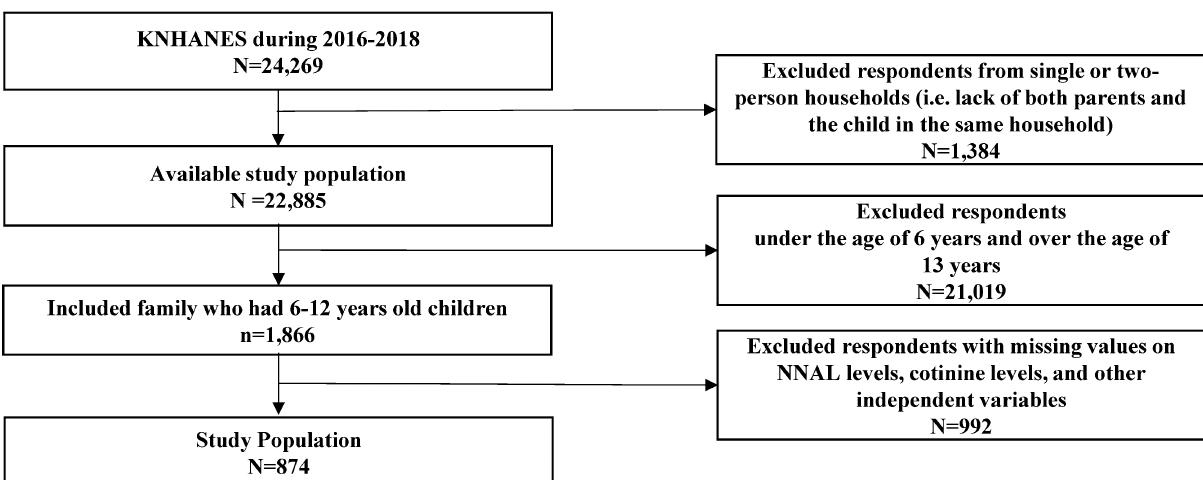
Figure 2. Participant flowchart. KNHANES Korea National Health and Nutrition Examination Survey, NNAL